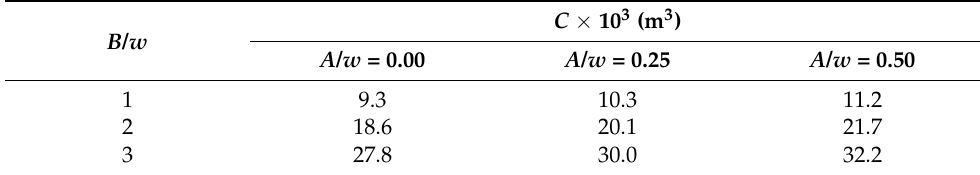
Figure 21. Relative efficiency of PKWs versus: ( a ) H o / P and A / w (subscripts of B 3 and B 1 respectively refer to B / w = 3 and 1), respectively;); ( b ) H o / P and B / w (subscripts of Tri, Tra, and Rec respectively refer to A / w = 0, 0.25, and 0.5, respectively). Table 4. Volume of PKW bodies ( C ) in the experimental scale with three keys.